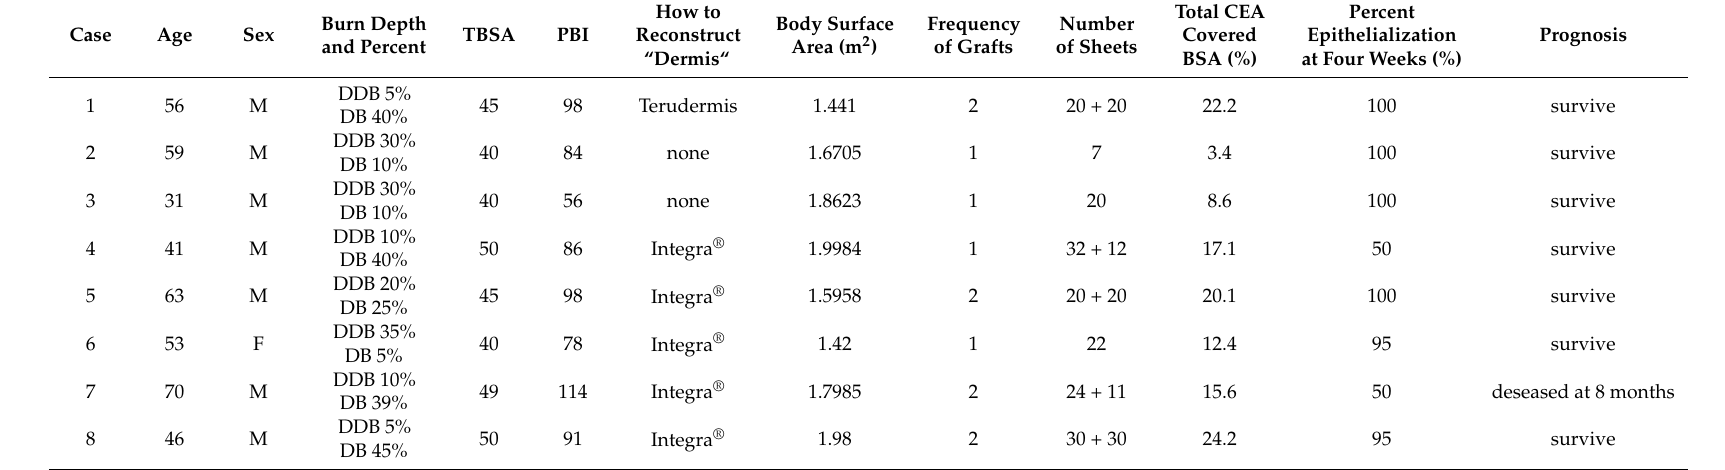
Table 6. Patient demographics. PBI: prognostic burn index. wks: